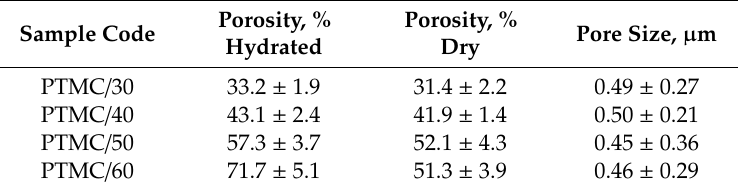
Figure 3. SEM pictures of cross-sections of leached PTMC / CaCO 3 composite films. ( A ) PTMC / 30; Table 3. Porosity and pore size of leached PTMC / CaCO 3 composite films.